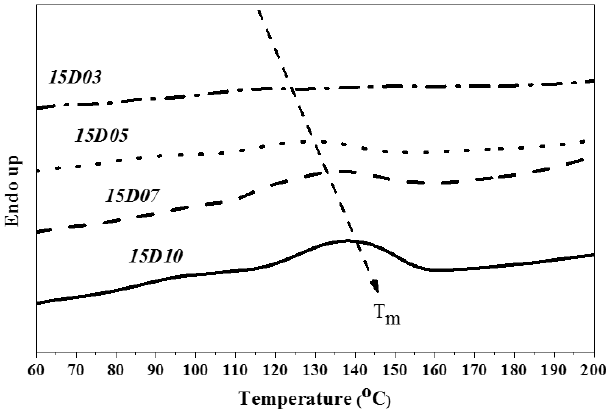
Figure 13. DSC curve of TPU with end-capping agent at concentration of 5.0 phm.